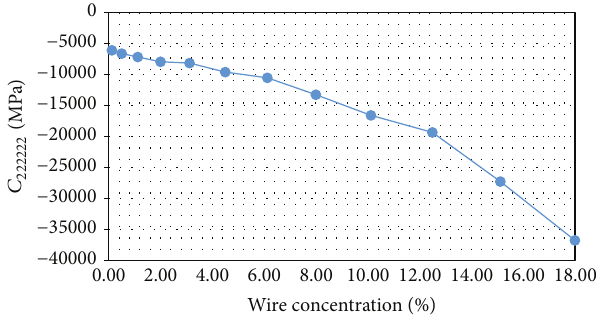
Figure 9: Dependence of coefficient versus form of reinforcing wires cross section.